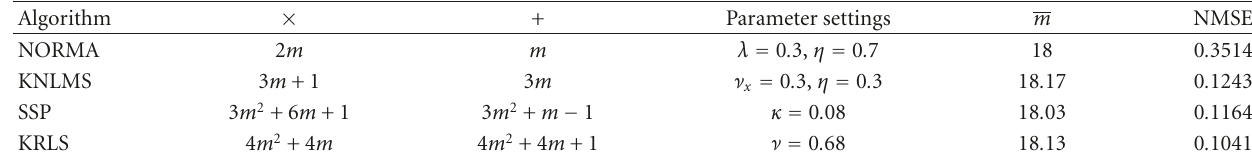
Figure 8: Spatial distribution of temperature estimated at time instants 10 (a) and 20 (b), when the heat sources are turned o ff and on. Table 3: Estimated computational cost per iteration, experimental setup and